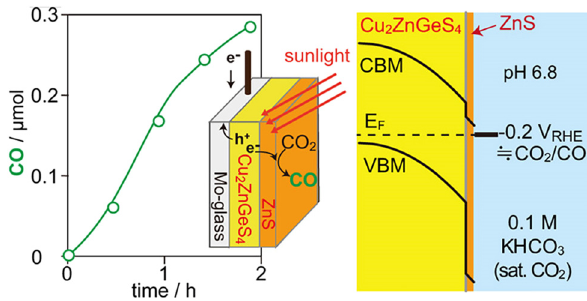
Figure 13: Time course curves of CO liberation over a ZnS/CZGS photocathode ( left ) and an estimated band alignment pro fi le at the solid - liquid interface for the photocathode with application of a potential at − 0.2 V RHE ( right ) . Reprinted with permission from ref. [ 96 ] . ©2019 American Chemical